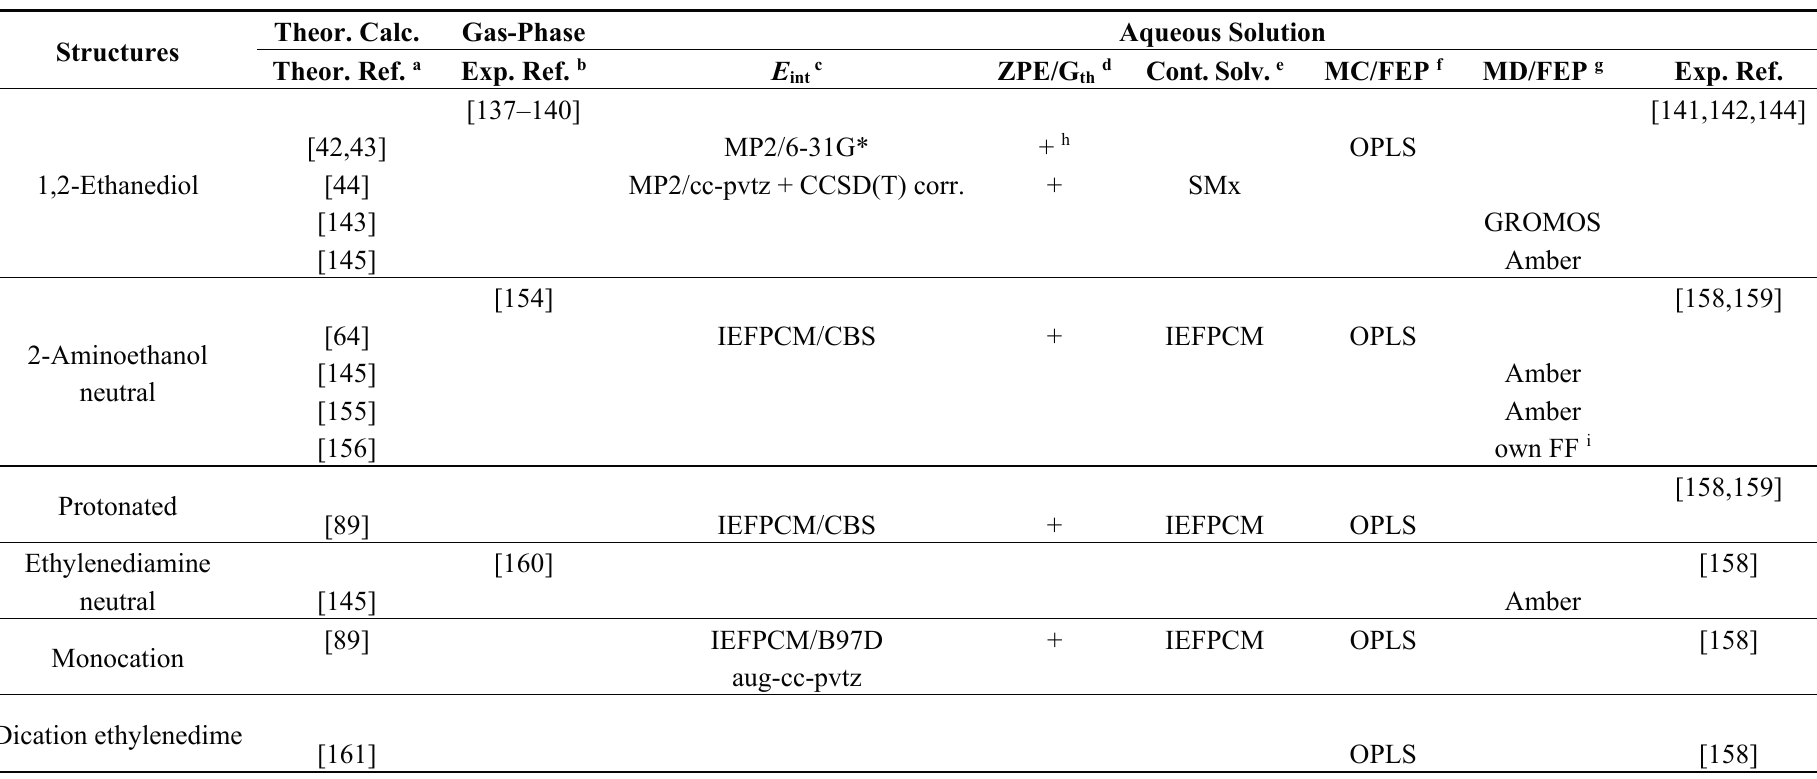
Table 1. Comprehensive summary of the applied experimental and theoretical methods for the conformational equilibria of some 1,2-disubstituted ethane derivatives in aqueous